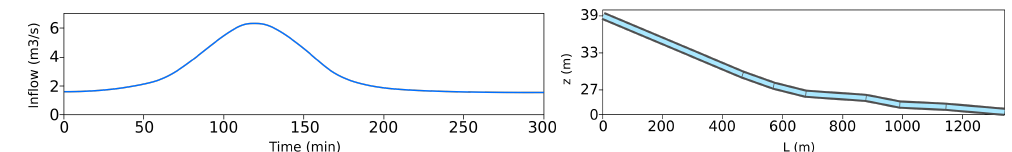
Figure 2. Case 1: DEM used, with the location of the manhole. The course of the underground pipe is indicated, although irrelevant to the modelling. Purple lines: outline of roads and pavements. Black lines: building outlines. Triangles: output point locations.